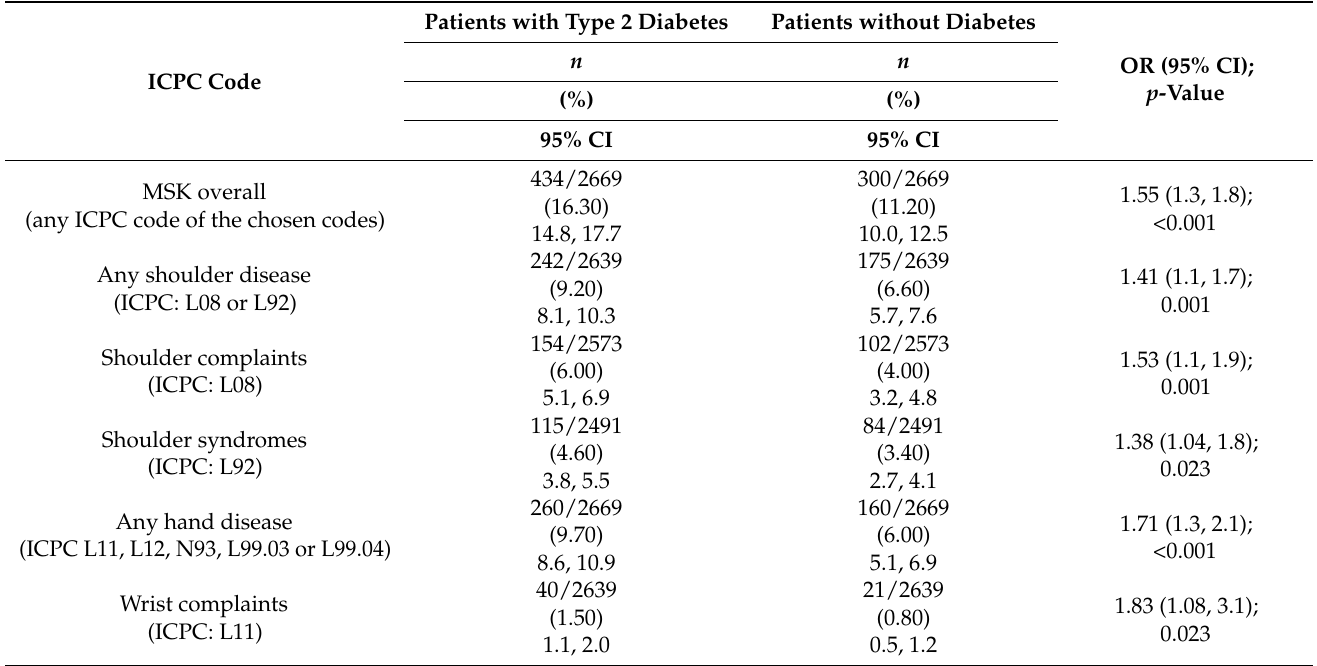
Table 2. Prevalence of specific upper extremity musculoskeletal disorders and their corresponding ICPC codes in patients with type 2 diabetes compared to patients without diabetes by logistic regression in RNFM approach, correcting for the matching variables age, gender and general